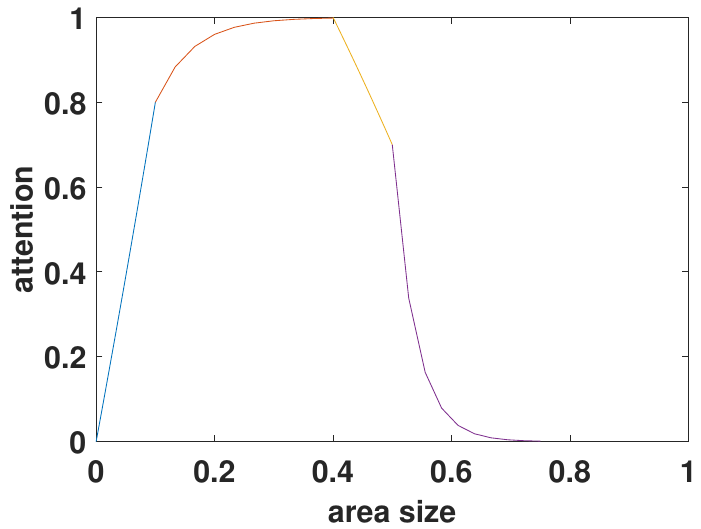
Figure 4. The function map of Equation (4).